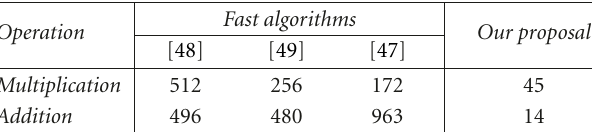
Figure 3: Growing rates s ( n ) and m ( n ) versus n . Table 14: Number of multiplication and addition operations for di ff erent 4 × 4 DCTs.